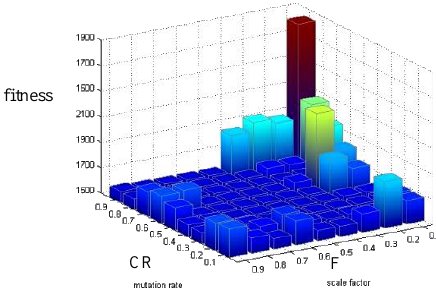
Figure 12. Relationship between the search performance (fitness) and different combinations of control parameters ( F and CR ).